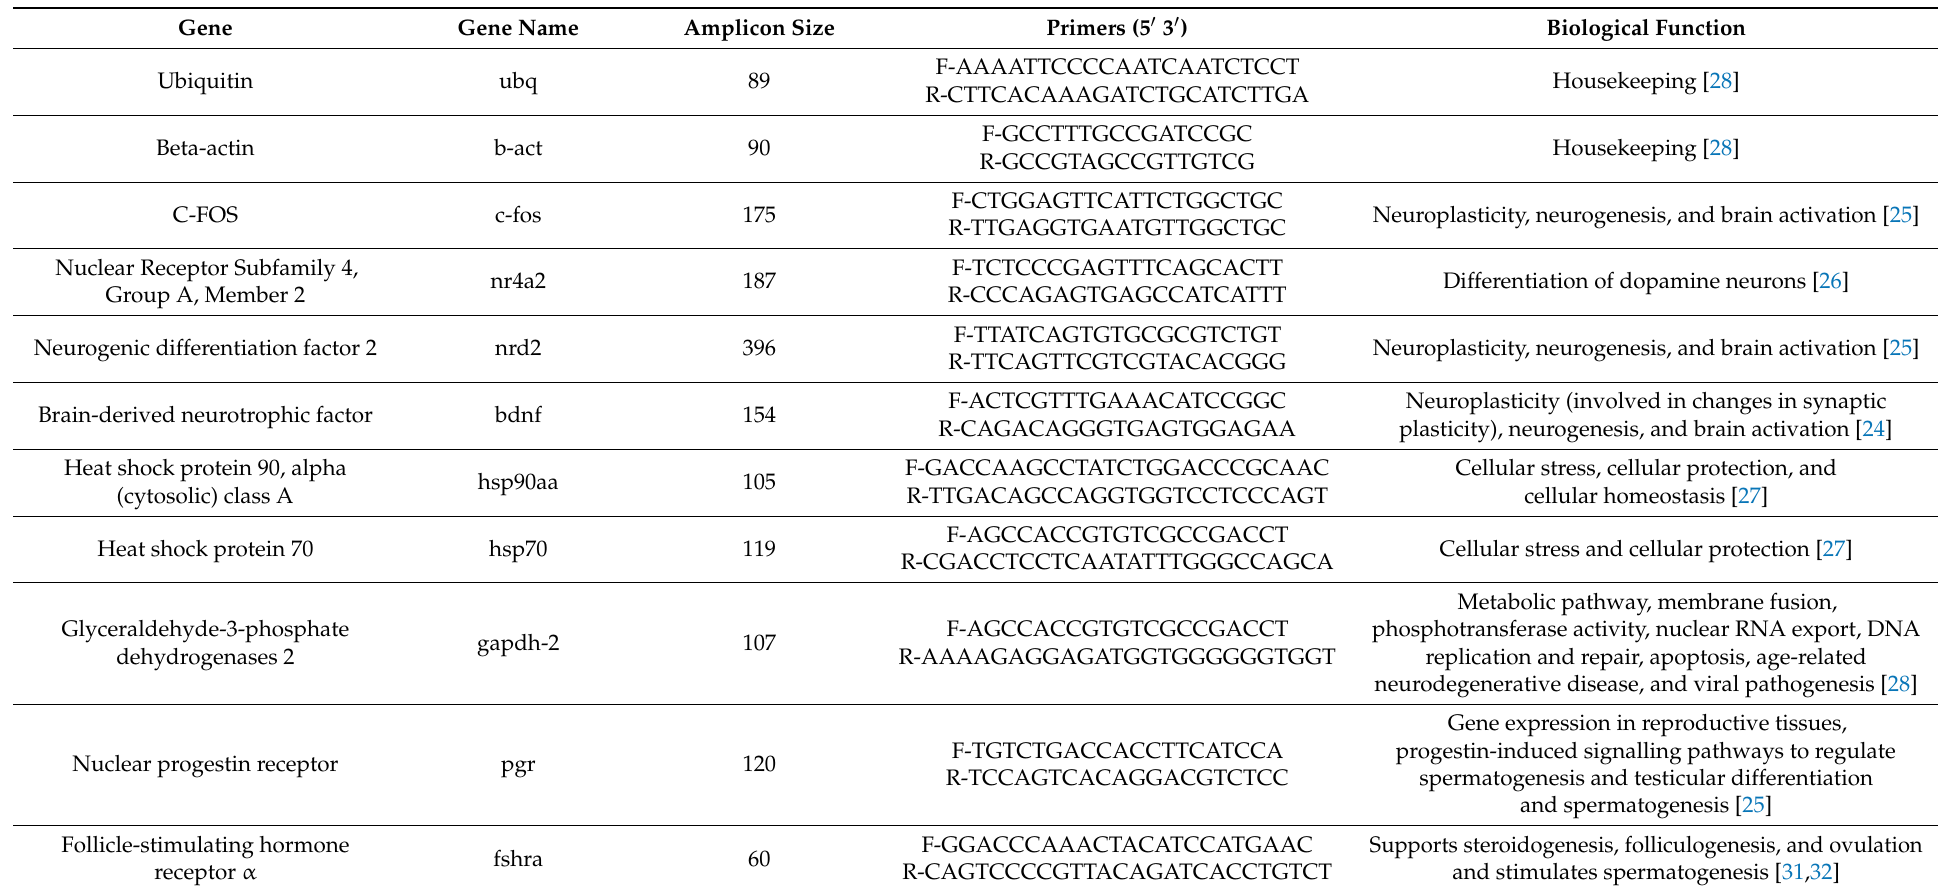
Table 2. Primers used for exploring transcript abundance in the brain of Senegalese sole ( Solea senegalensis ) related to dominance category and presence of an enriched environment. Gene, gene name, amplicon size, primer sequence and biological function are